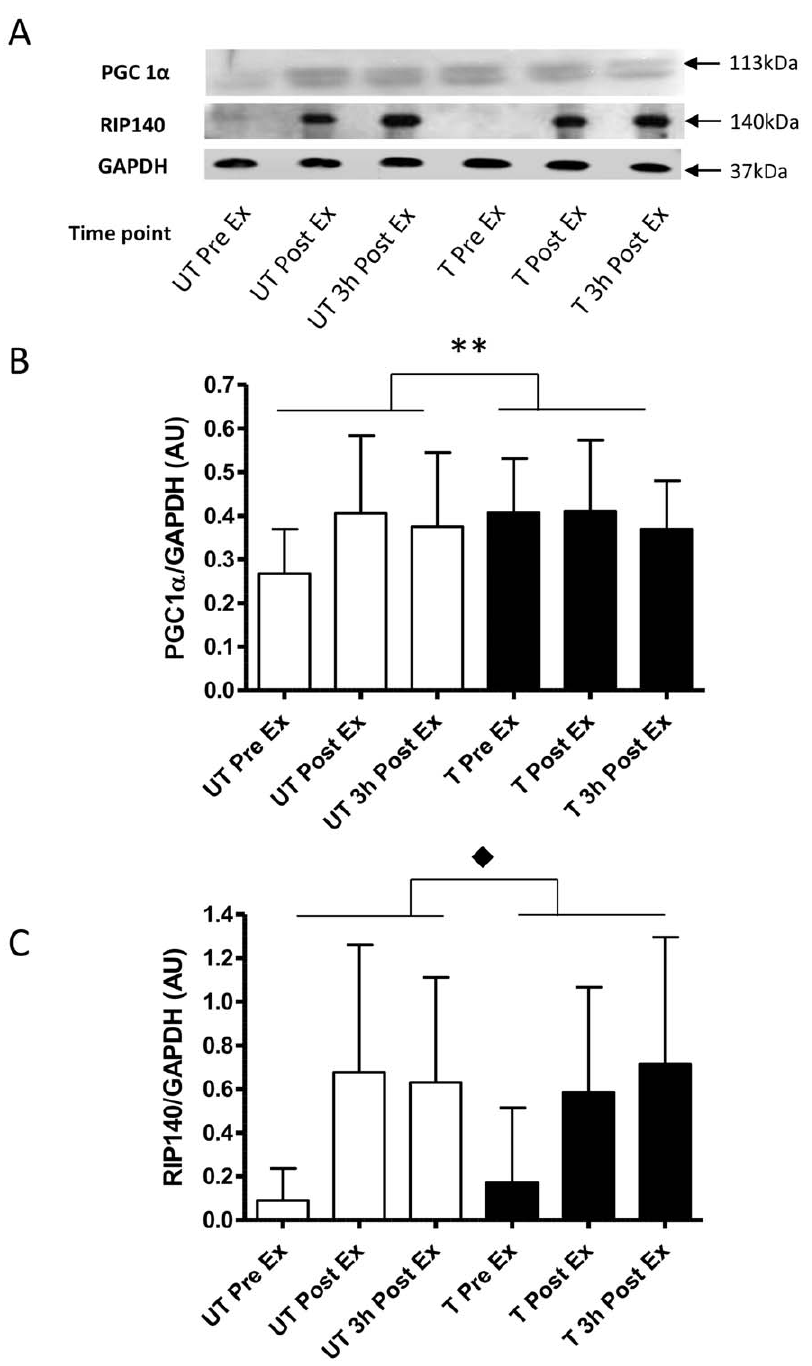
Figure 4. Normalised protein expression changes of the transcription factor co-activator and the co-repressor in response to the same 1 h cycling bout ( , 164W or , 72% VO 2peak )before and after 10-d of intensified cycle training. A- representative immunoblots, B- peroxisome proliferator-activated receptor c co-activator -1 a (PGC-1 a ) and C- receptor interacting protein 140 kDa (RIP140). Data are mean 6 SD for n=9. pre-training exercise bout (open bars); post-training exercise bout (closed bars); Pre Ex-resting sample just prior to exercise; Post Ex-sample immediately after exercise; 3 h Post Ex -sample take 3 h after exercise; **- training x time interaction P , 0.05; X -main effect of time P , 0.01.